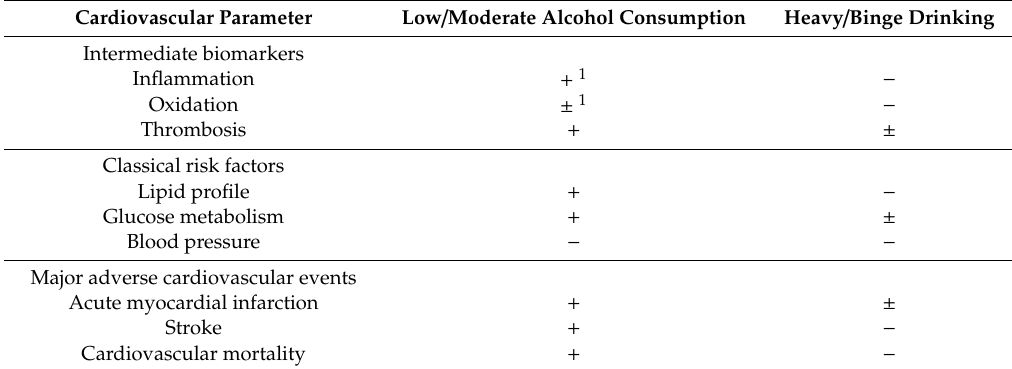
Table 2. E ff ects of alcohol consumption in cardiovascular risk biomarkers, classical risk factors, and major events according to the amount of alcohol